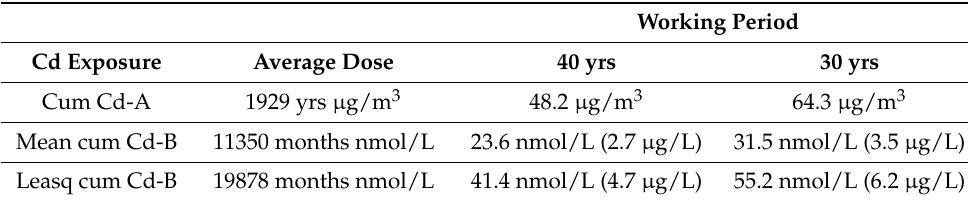
Table 1. Averages of cumulative cadmium exposure and cadmium concentrations corresponding to the entire working period of 40 or 30 yrs.